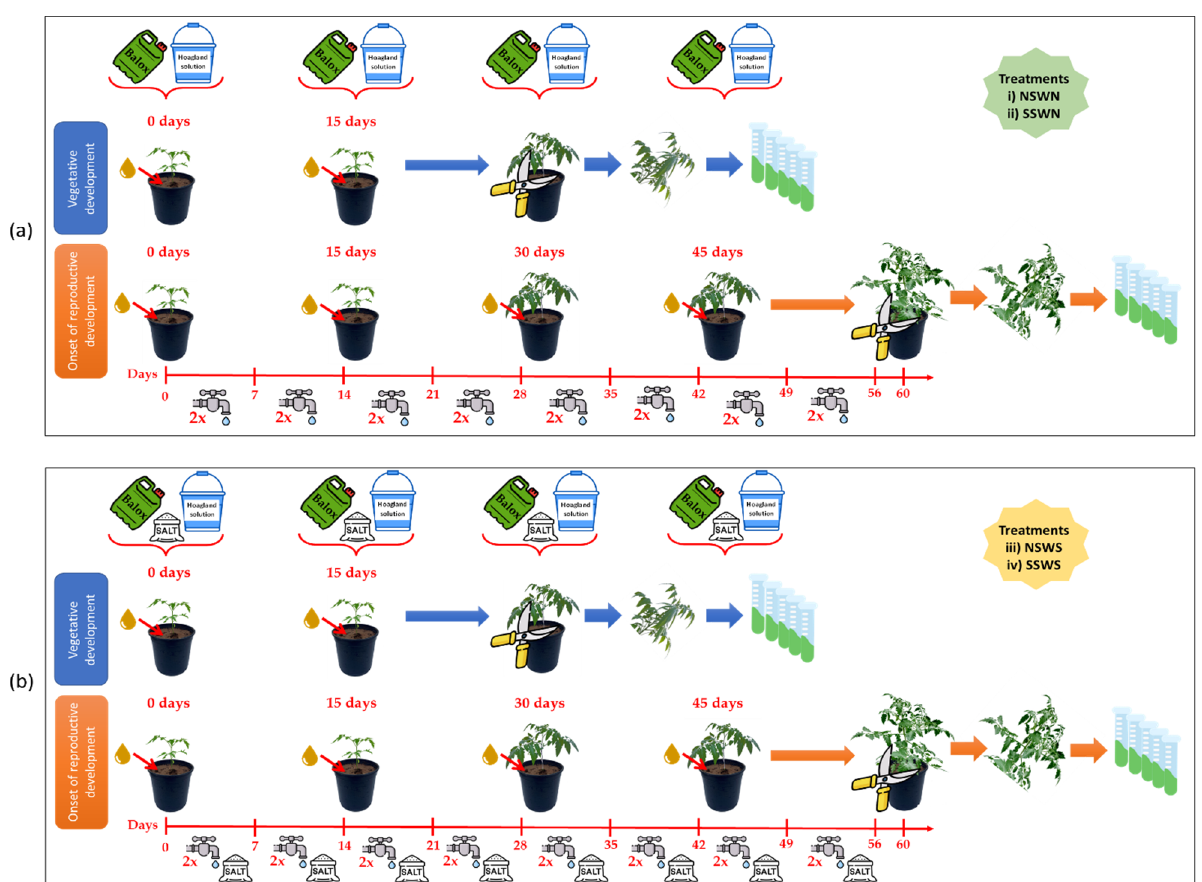
Figure 14. Scheme of the irrigation and biostimulant application on Solanum lycopersicum plants sub- jected to transplantation to different combinations of soil salinity and irrigation water in each period (vegetative development: 30 days; beginning of reproductive development: 60 days). Treatments: (i) NSWN: Non-saline soil (EC = 2.28 dS/m) and non-saline water (EC = 0.91 dS/m); (ii) SSWN: Saline soil (EC = 8.55 dS/m) and non-saline water (EC = 0.91 dS/m); (iii) NSWS: Non-saline soil (EC = 2.28 dS/m) and saline water (EC = 10.50 dS/m); (iv) SSWS: Saline soil (EC = 8.55 dS/m) and saline water (EC = 10.50 dS/m). Two formulations of the biostimulant were applied independently: B1, 1.4% ( w / w ) polyphenols and 3.0% ( w / w ) glycine betaine, and B2, 1.4% ( w / w ) polyphenols and 5.0% ( w / w ) glycine betaine. In addition to the controls (D0), two different doses of the biostimulant were also independently applied for each treatment: 0.4 mL L −1 (D1) and 0.8 mL L −1 (D2). The total number of plants used in the experiments was 120.